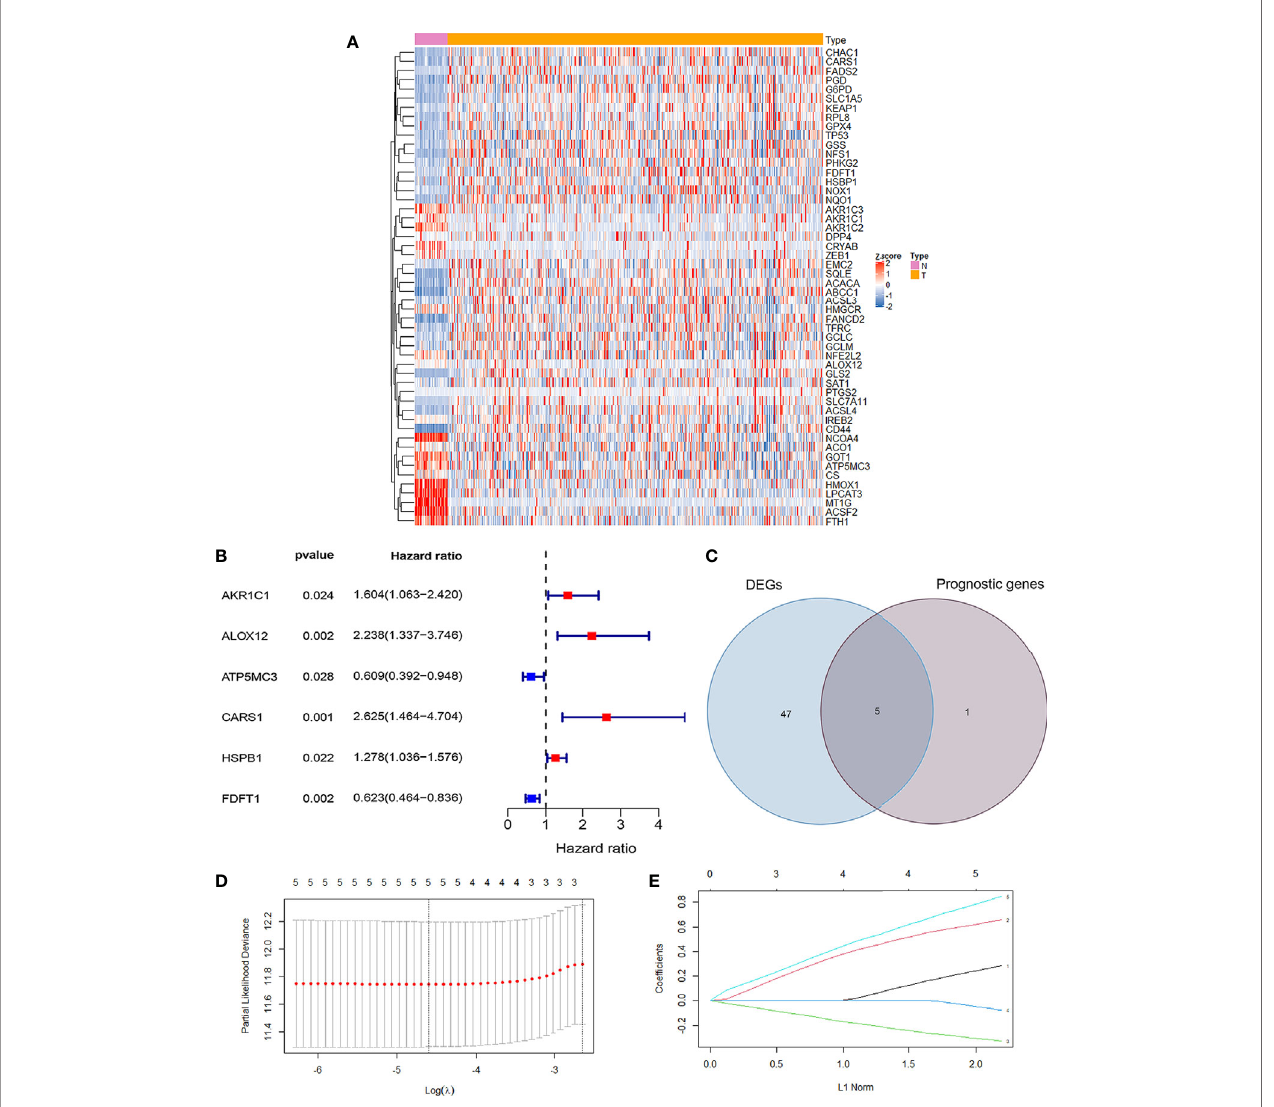
FIGURE 1 | Development of ferroptosis related gene signature in colon cancer. (A) The heatmap showed the differentially expressed genes (DEG) related ferroptosis between normal population and colon cancer population from TCGA (P <0.05). (B) The forest map showed six prognosis related genes in colon cancer by univariate cox regression analysis (P <0.05). (C) The Venn diagram showed the intersecting genes between DEG and survival related genes. (D) Partial likelihood deviance against log ( l ) is plotted. The fi rst vertical dashed line representatives the l value with minimum error. (E) The LASSO coef fi cient pro fi les of ferroptosis-related gene in colon